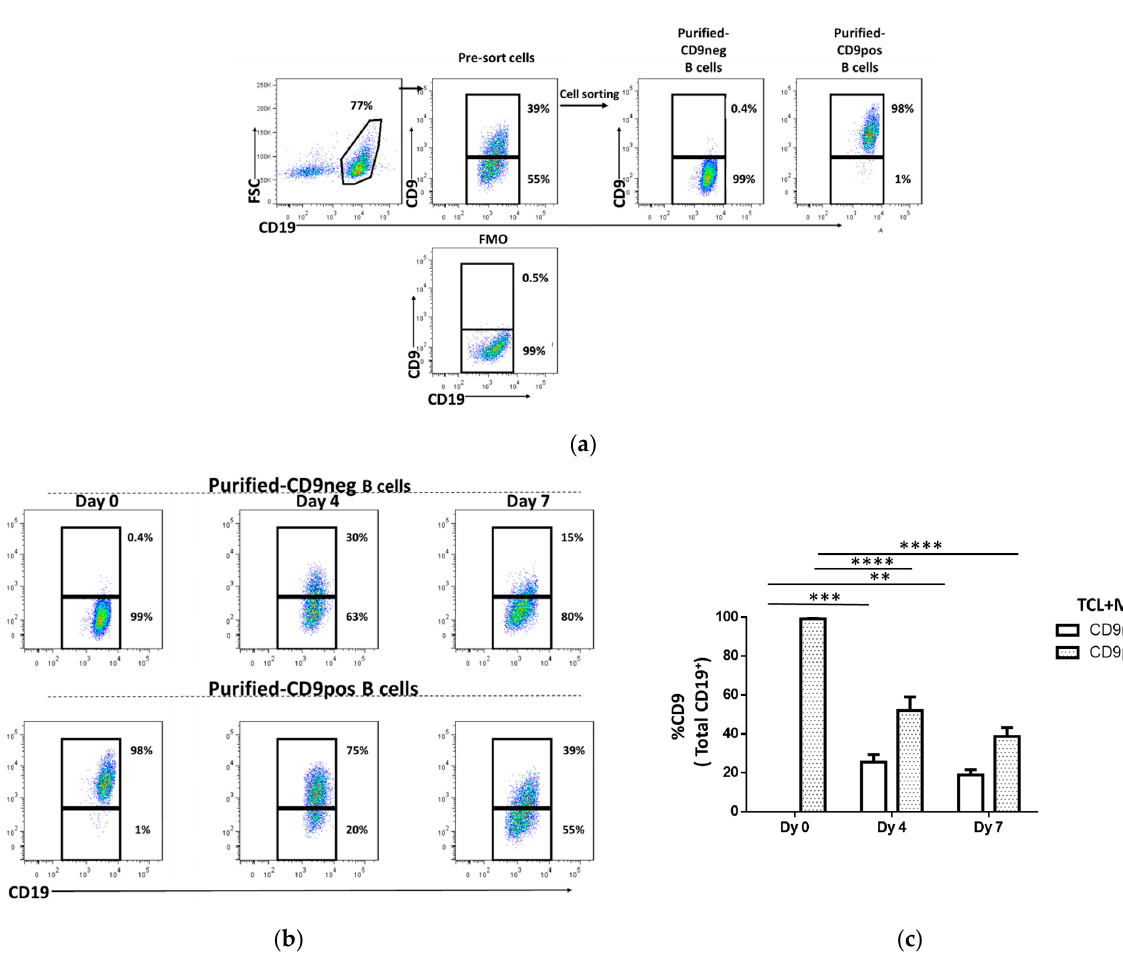
Figure 3. CD9 expression on B cells is transient. Tonsil cells were sorted into purified CD19 + CD9 - (CD9neg) and CD19 + CD9 + (CD9pos) B cells then cultured under the transitional cell-inducing condition with T-cell like (TCL) stimulation + MSC. At days 4 and 7, changes in the CD9 surface expression were analyzed with flow cytometry. ( a ) Representative dot plots showing the purity of CD9neg and CD9pos B cells. ( b ) Representative dot plots showing time-dependent changes in CD9 expression of the purified CD9neg and CD9pos B cells. ( c ) Significant gain and downregulation of CD9 expression in the purified CD9neg and CD9pos B cells, respectively. Data show at least three independent experiments in each group. ** p < 0.01, *** p < 0.001, **** p < 0.0001. Two-way ANOVA with multiple comparisons was performed to determine statistical